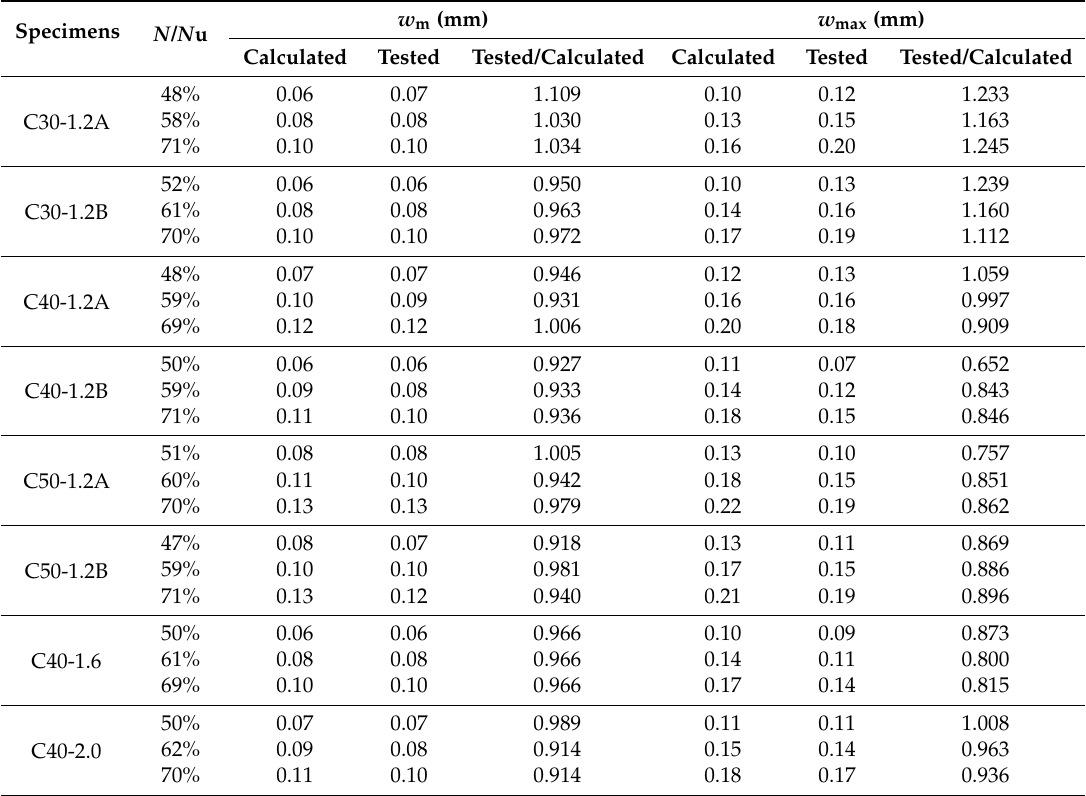
Table 9. The calculated and tested values of the average ( w m ) and maximum crack width ( w max ) of the tested